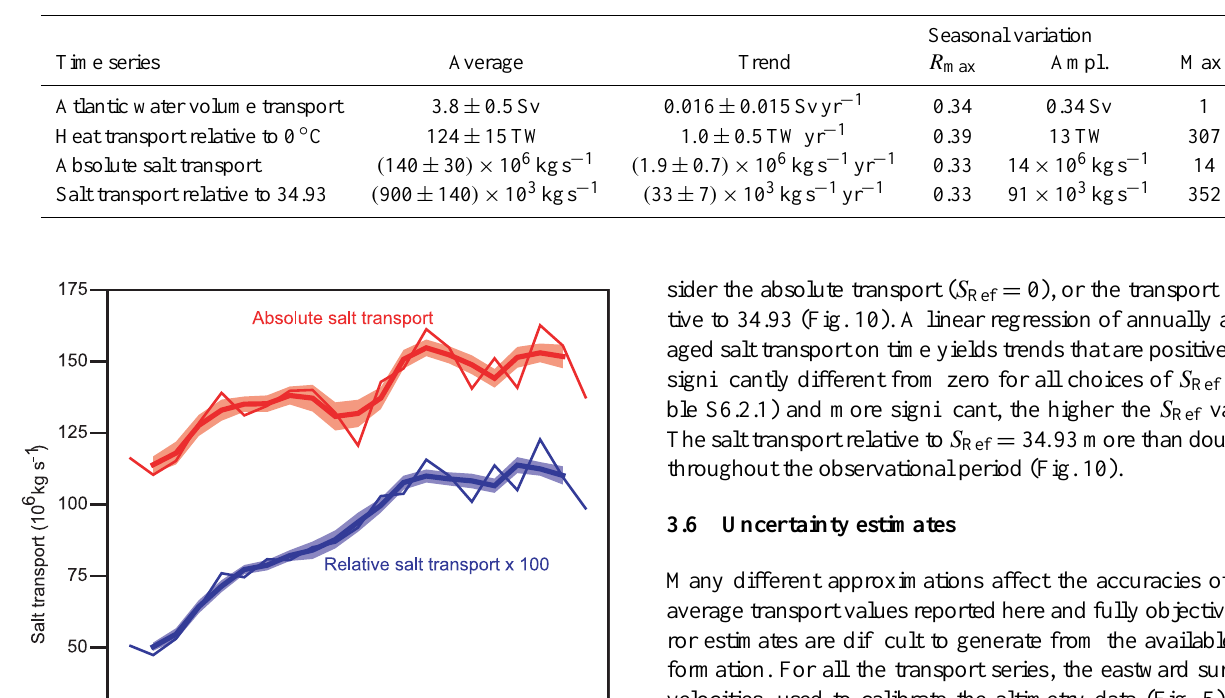
Table 3. Characteristics of transport time series. Averages for the 1993–2013 period. Trends are based on a linear regression of annual averages on time with 95% confidence intervals. Seasonal variation is determined by an iterative procedure (Appendix B in the Supplement) where “ R max ” is the maximum correlation coefficient with a sinusoidal seasonal signal, “Ampl.” is the seasonal amplitude and “Max.” is the day number in the year with maximum value.